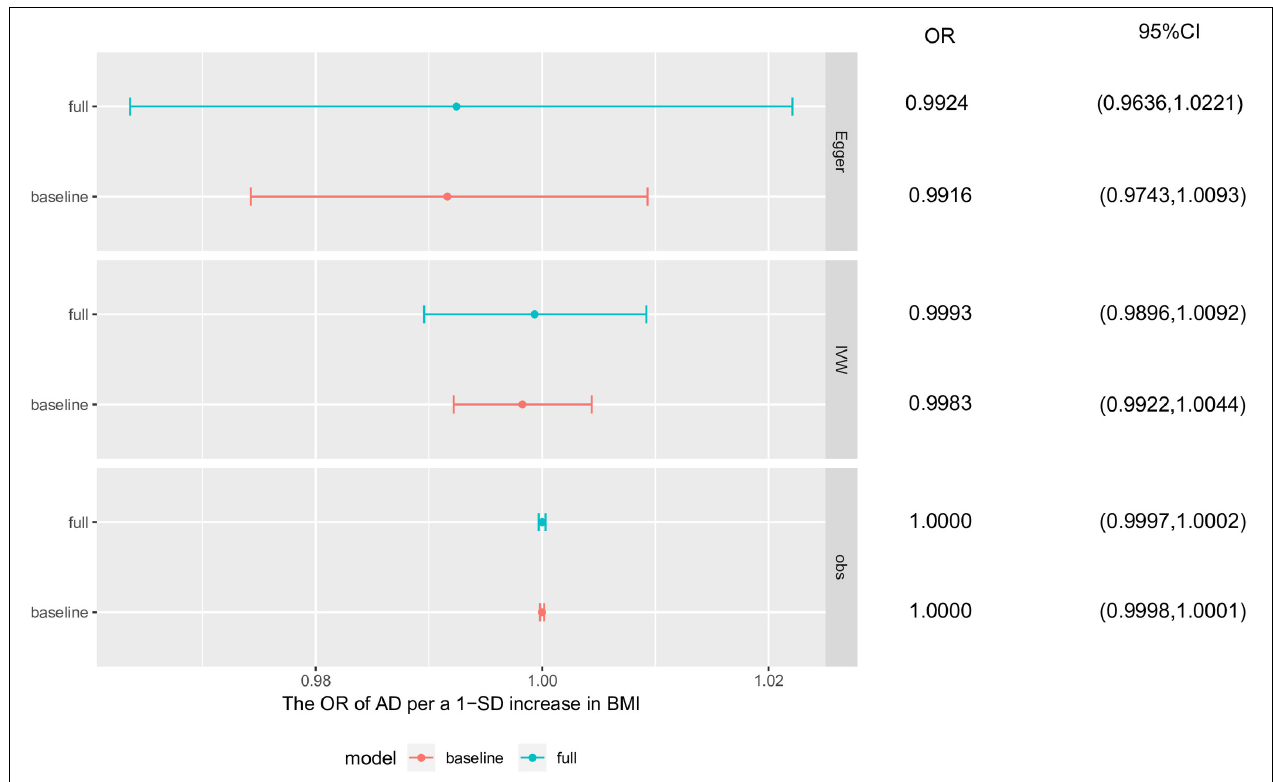
FIGURE 4 | Survivor bias. The causal effects of these simulation analyses were obtained separately from base survivor model and full survivor model using observational study, inverse-variance weighted method and MR-egger method. Each point and horizontal line denote the mean estimated causal effect and 95% confidence interval (CI) from corresponding model and method. AD, Alzheimer’s disease; BMI, body mass index; baseline, baseline survivor model without survivor bias; full, full survivor model with selected